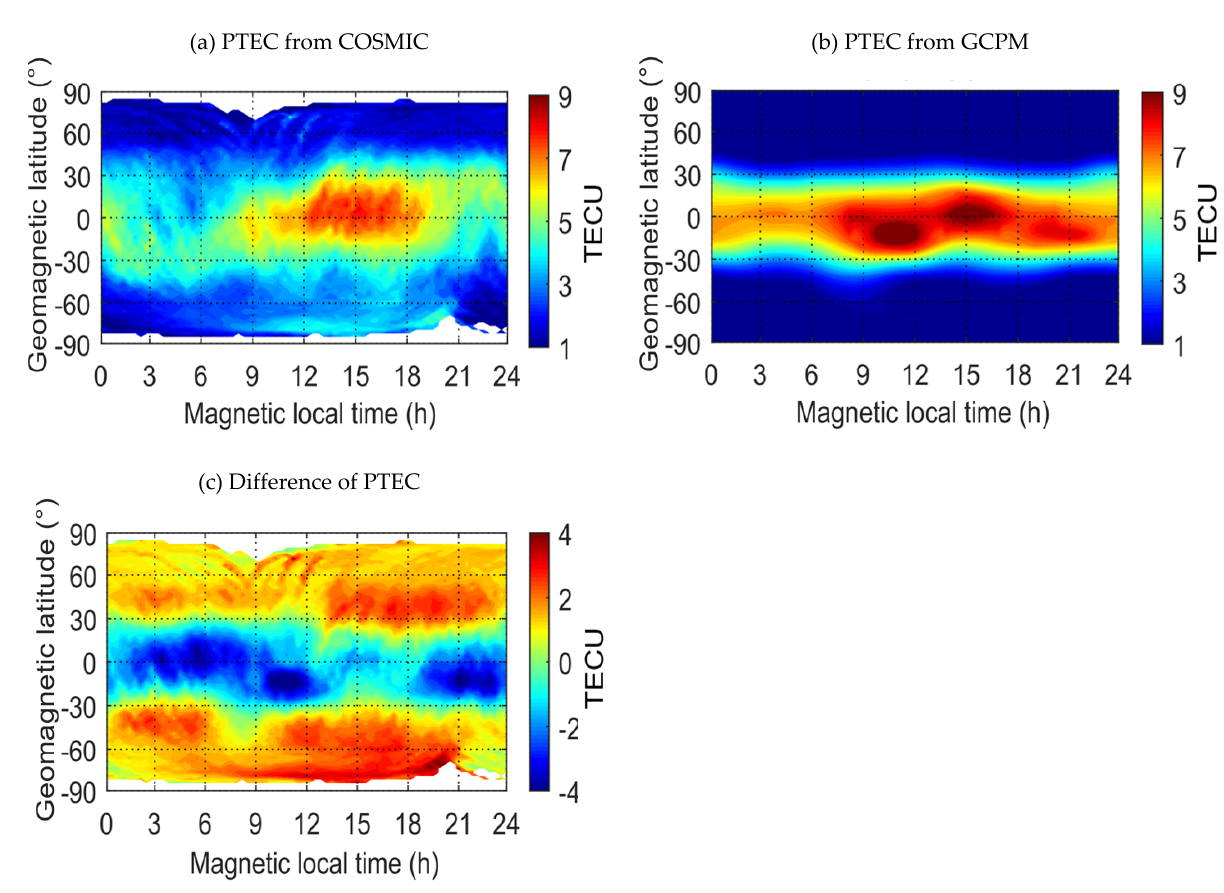
Figure 3. Comparison of PTEC from topside GPS observations of COSMIC and GCPM in January 2008 (The altitude range is from about 800 km to 20,200 km): ( a ) PTEC from COSMIC, ( b ) PTEC from GCPM, and ( c ) difference of PTEC.